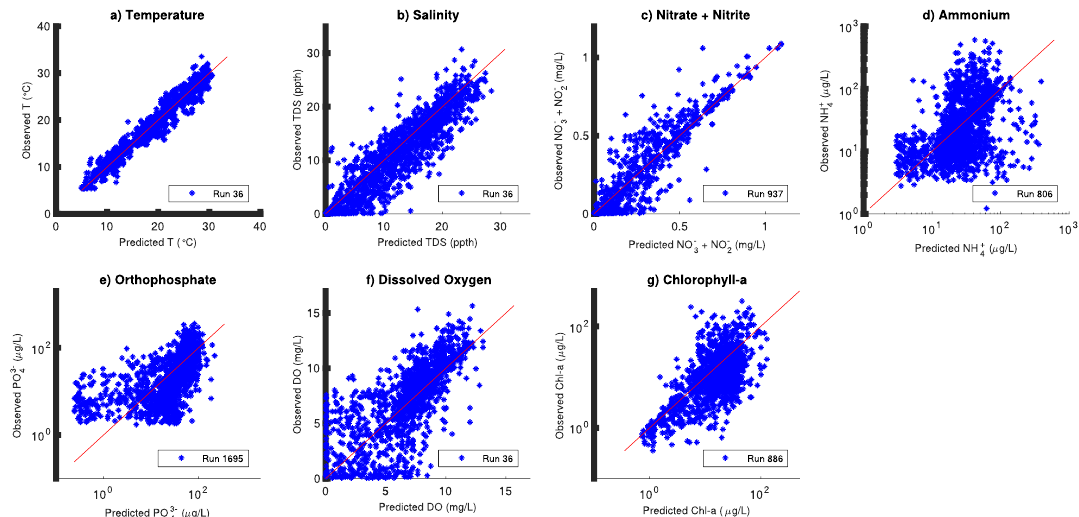
Figure 6. Predicted versus observed scatter plots for hydrodynamic and water quality parameters for 2006–2008. The predicted = observed line is shown in red. Panels show ( a ) temperature, ( b ) salinity, ( c ) nitrate + nitrite, ( d ) ammonium, ( e ) orthophosphate, ( f ) dissolved oxygen, and ( g ) chlorophyll-a.